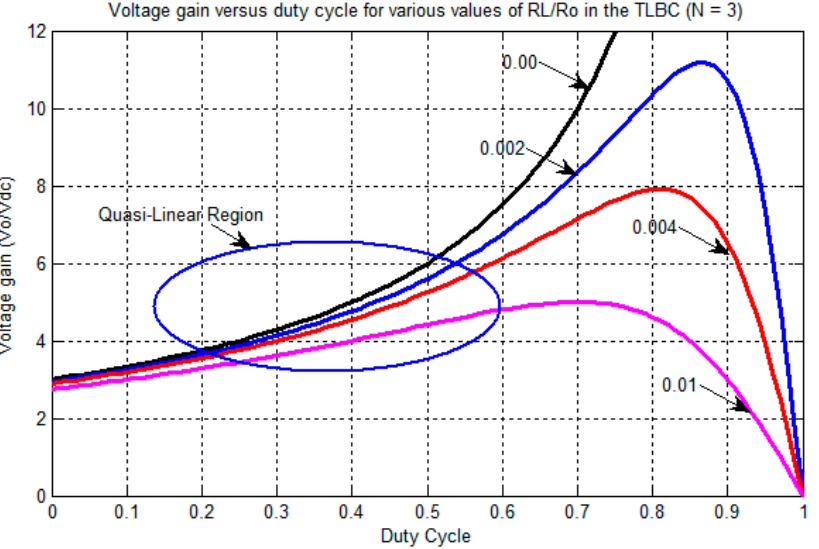
Figure 4. Duty cycle versus voltage gain of TLBC for various values of R L / Ro ( N = 3).